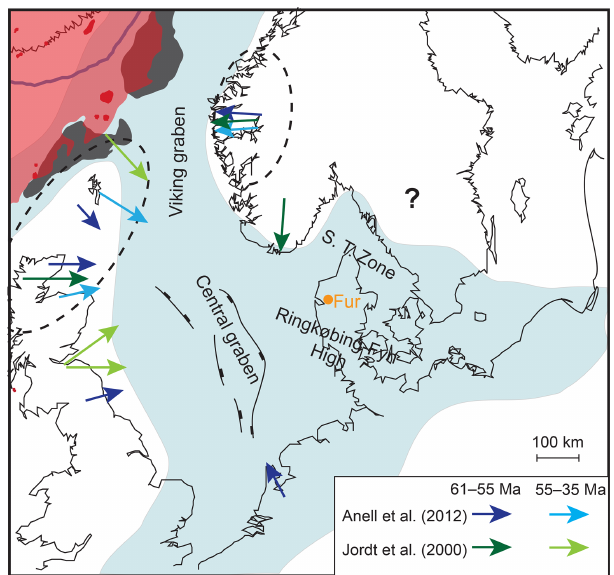
Figure 11. Close up of Fig. 1 with modifications based on Schiøler et al. (2007). See Fig. 1a for colour legend. Dashed circles indi- cate main sedimentary source areas for the North Sea during the Paleocene and Eocene from Anell et al. (2012). Arrows indicate the main sediment transport directions based on Jordt et al. (2000) and Anell et al.